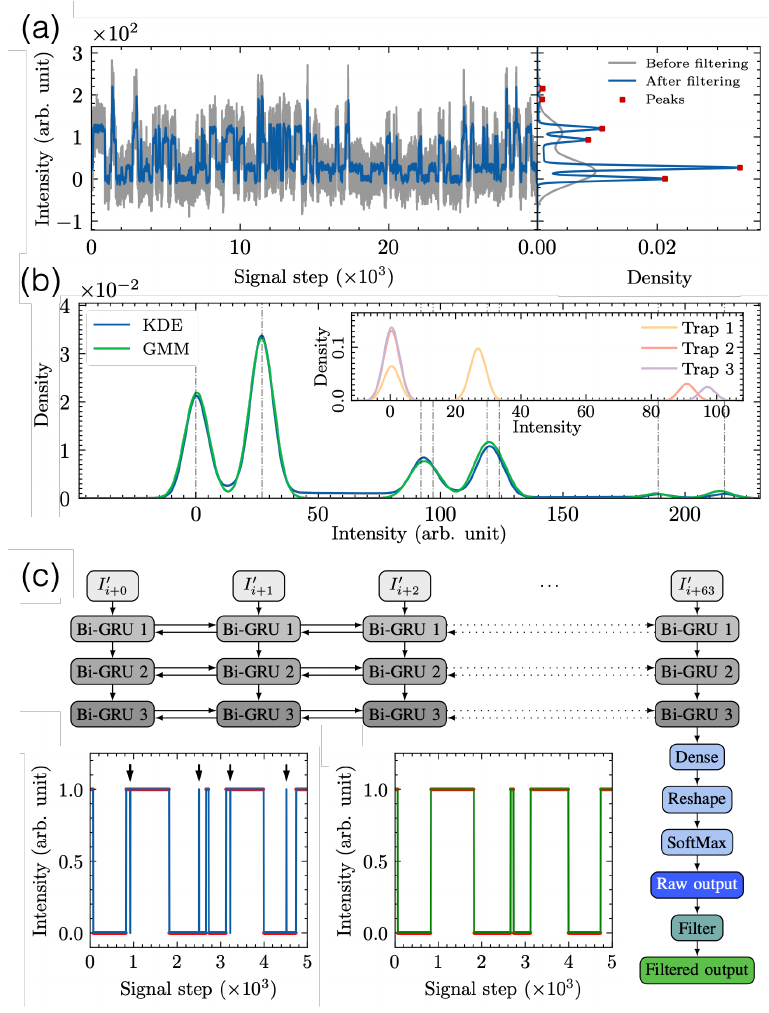
Figure 3. ( a ) (Left) A time-trace segment of a two-trap random telegraph signal with Gaussian background white noise with before (gray) and after (blue) moving average filtering in Step 1. (Right) The continuous kernel density plots are given with much sharper peak distributions for the filtered signals. ( b ) In Step 2, individual traps are decomposed from the kernel density estimate (KDE, pink) and Gaussian mixture model (GMM, green). Both results are consistent in this case since the white noise is not severe. ( c ) The structure of a bidirectional recurrent neural network in Step 3, where I (cid:48) is the raw intensity signal ( I ) normalized to between zero and one, 0 to 63 is the index within the batch, and i is the batch’s offset from the first value in the signal. (Inset) Digitization errors are false switching events due to background noise indicated by arrows (left) in comparison to the synthesized ground-truth data